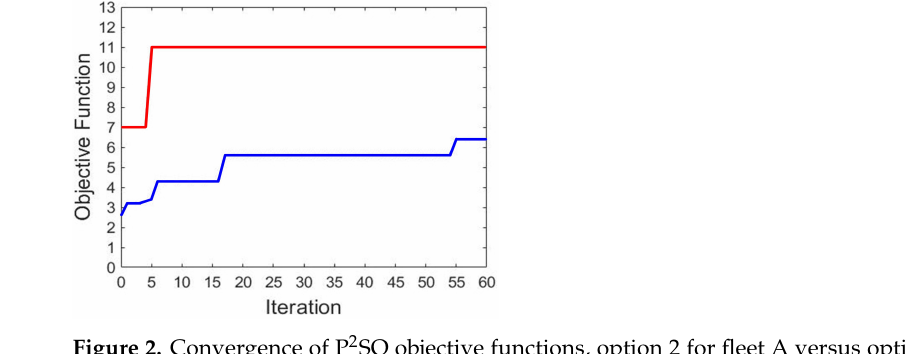
Figure 2. Convergence of P 2 SO objective functions, option 2 for fleet A versus option 3 for fleet B (A2/B3), ———: fleet A, ———: fleet B.